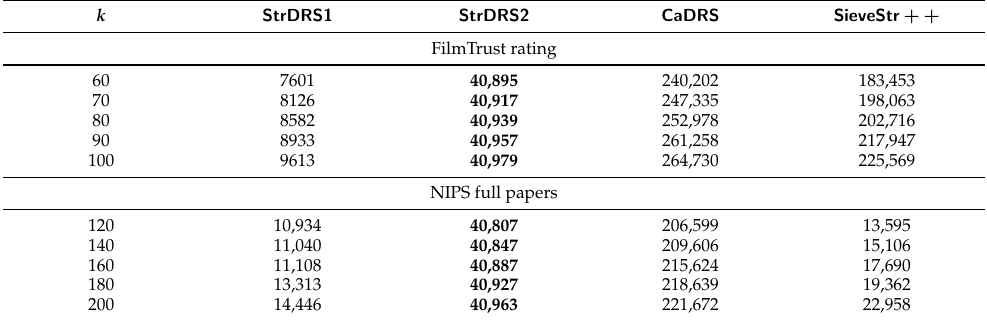
Table 4. Statistics of the number of queries.